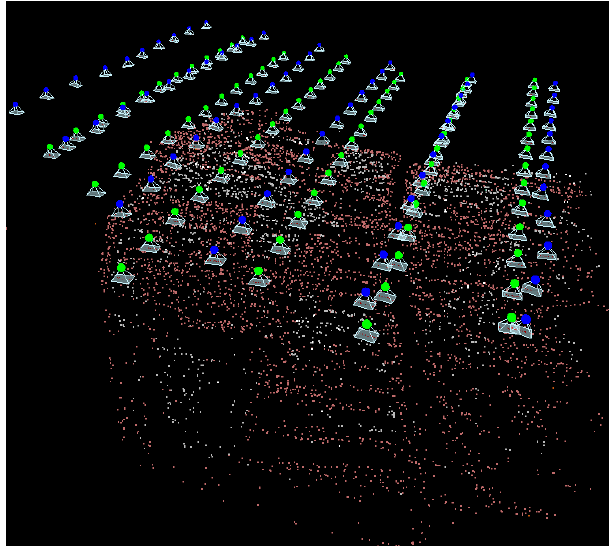
Figure 3. United bundle adjustment aerial triangulation results of images from two unmanned aerial vehicle (UAV) flights. The green dots are those images from the reference flight and the blue dots are images from the following flight.